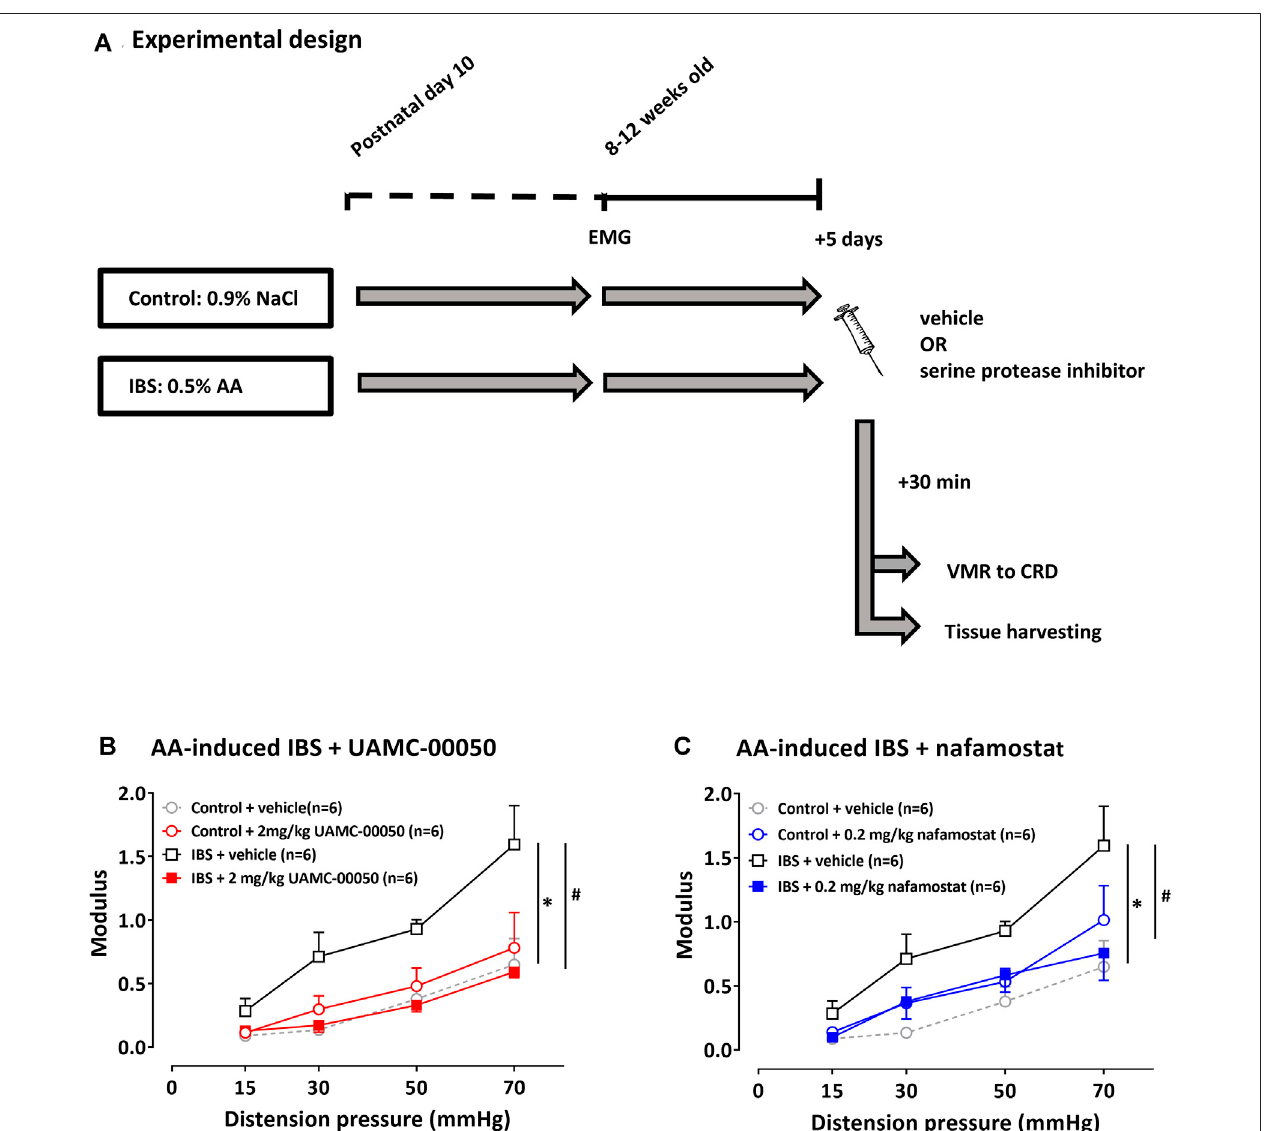
FIGURE3| The effect of UAMC-00050 (2 mg/kg), nafamostat mesylate (0.2 mg/kg) and vehicle (1% DMSO) on VMRs in AA-induced IBS and control mice. (A) Overview of the experimental design in acetic acid-induced IBS mice. On postnatal day 10, mice received an intrarectal administration with AA (IBS) or 0.9% NaCl (control). In their adulthood (8 – 12 weeks old), EMG electrodes were implanted and 5 days later visceral sensitivity was assessed by VMR to CRD after a single i. p. injection with serine protease inhibitor/vehicle. AA: acetic acid; CRD: colorectal distension; EMG: electromyographic; IBS: irritable bowel syndrome; VMR; visceromotor response. (B) The effect of UAMC-00050 on VMRs in AA-induced IBS and control mice. (C) The effect of nafamostat mesylate (0.2 mg/kg) on VMRs in AA-induced IBS and control mice. Data are presented as mean ± SEM. Generalized Estimating Equations (GEE) and pairwise comparisons of group-speci fi c means were performed using the LSD post-hoc test; n = 6/group; * p < 0.05; signi fi cantly different from control + vehicle. # p < 0.05; signi fi cantly different from IBS + vehicle.